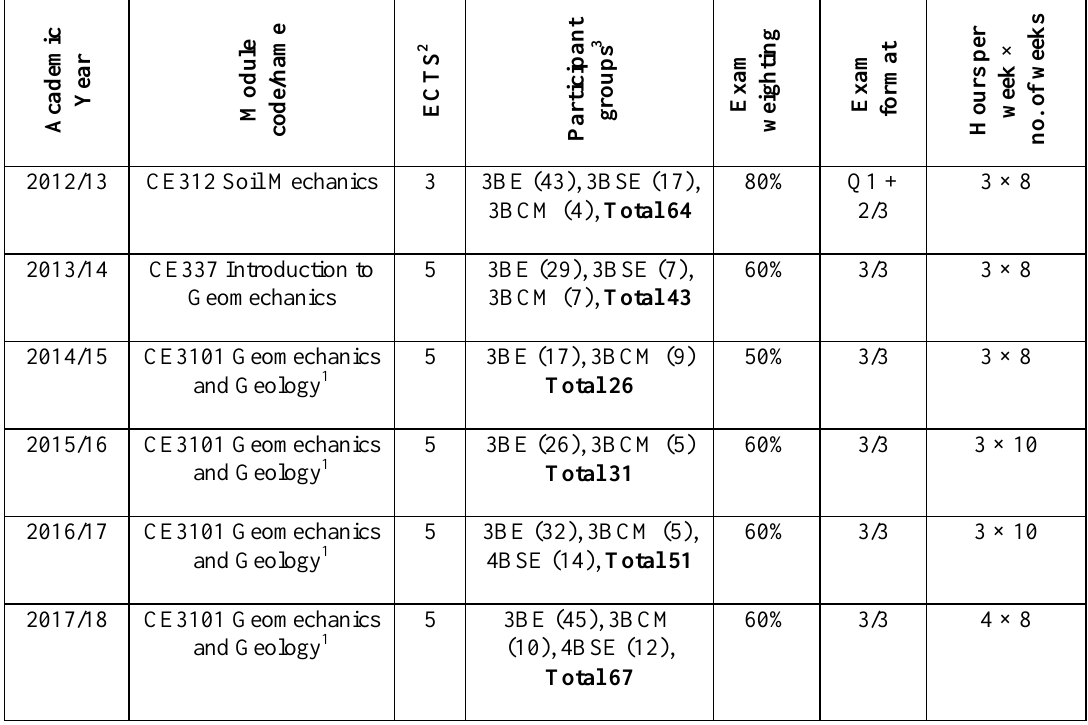
Table 1: Details of six years of teaching Soil Mechanics/Geomechanics in flipped mode c m i a e d e Y a c A